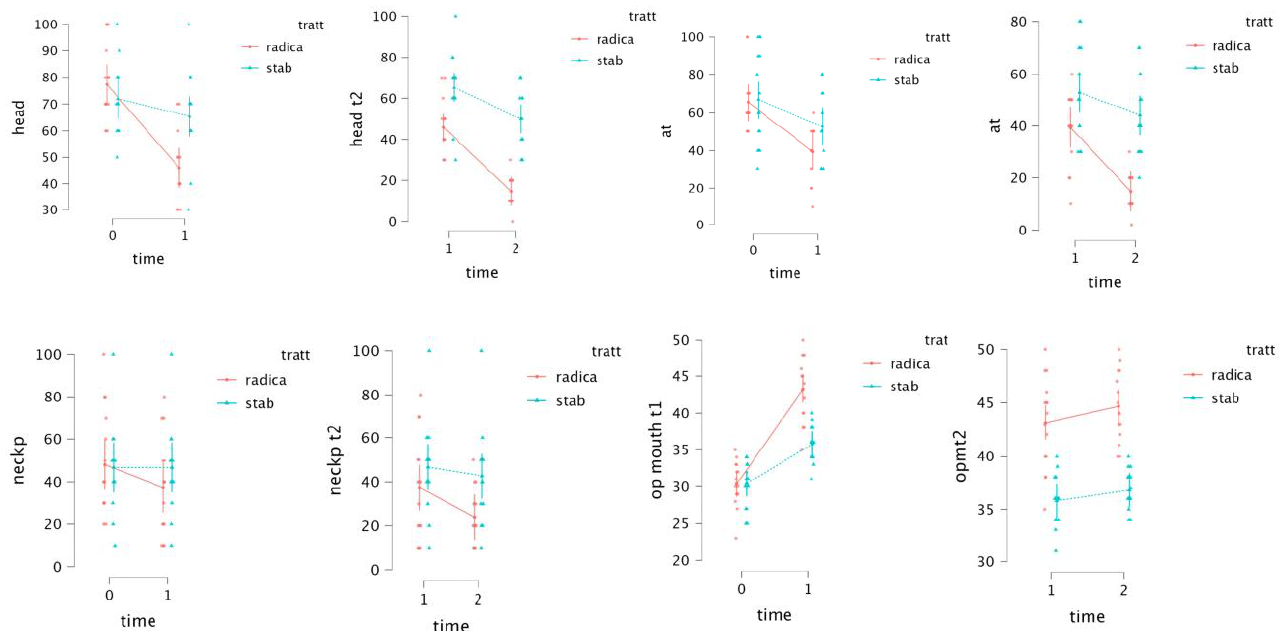
As for within-subject factors, there is an effect of time with a statistical significance of p < 0.05 in all of the parameters analyzed and time lapses. There is also a recognizable and significative interaction between treatment and time, except for jaw opening between T0 and T1 (Table 3). Figure 4 shows the trend in symptomatological and functional values in relation to time and type of treatment used.